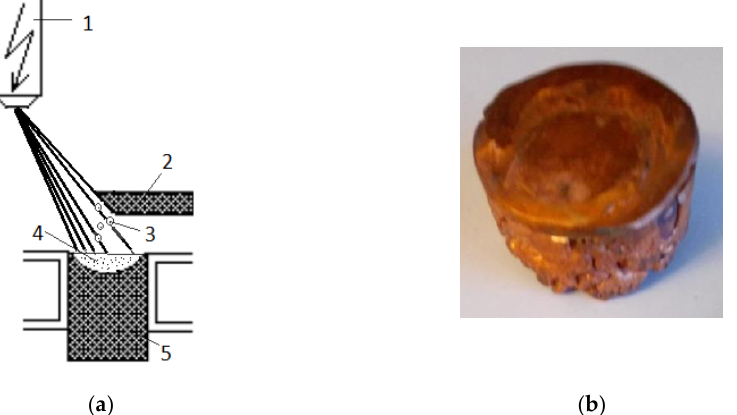
Figure 1. ( a ) Principal scheme of the EBMR process: (1) electron optical system; (2) started metal rod; (3) generated droplets; (4) molten pool in the water-cooled crucible; (5) metal ingot; ( b ) fabri- cated copper sample.